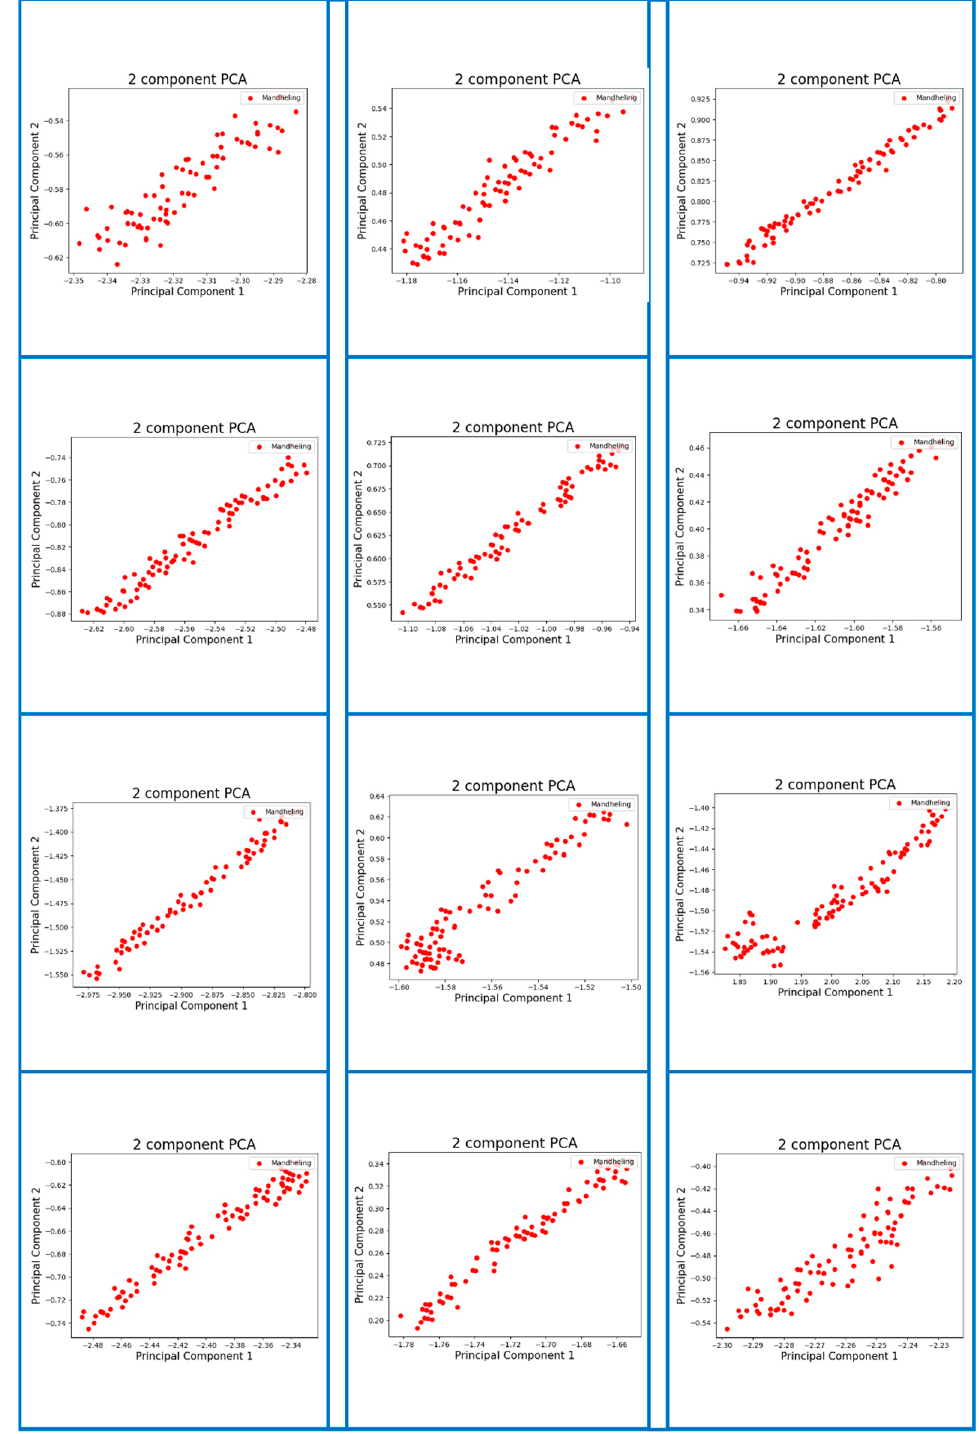
Figure A5. Sample digital fingerprints of coffee aromas originating from Mandheling, Indonesia.